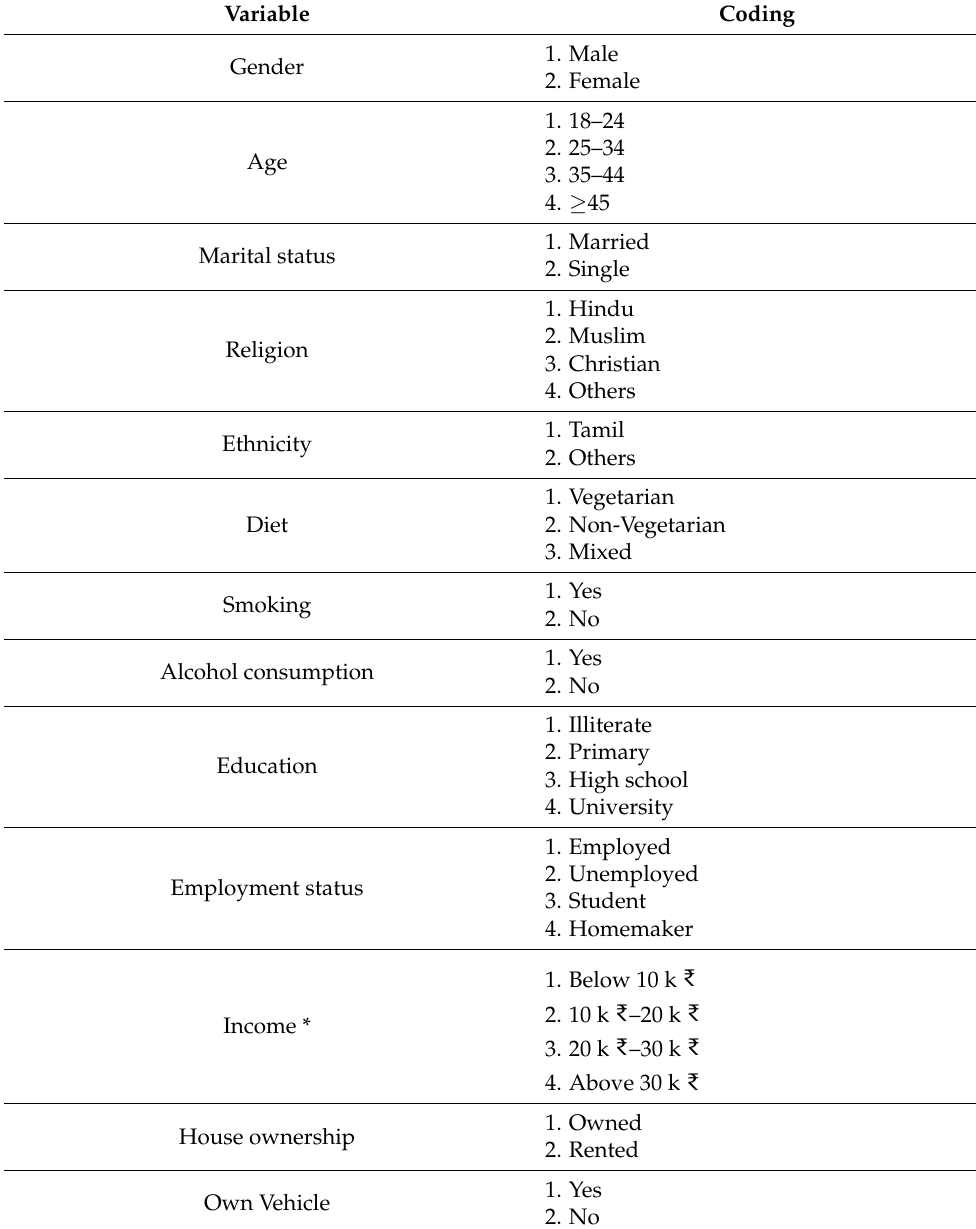
Table 3. Associated factors analysed among adults, Tamil Nadu, India, 2021.